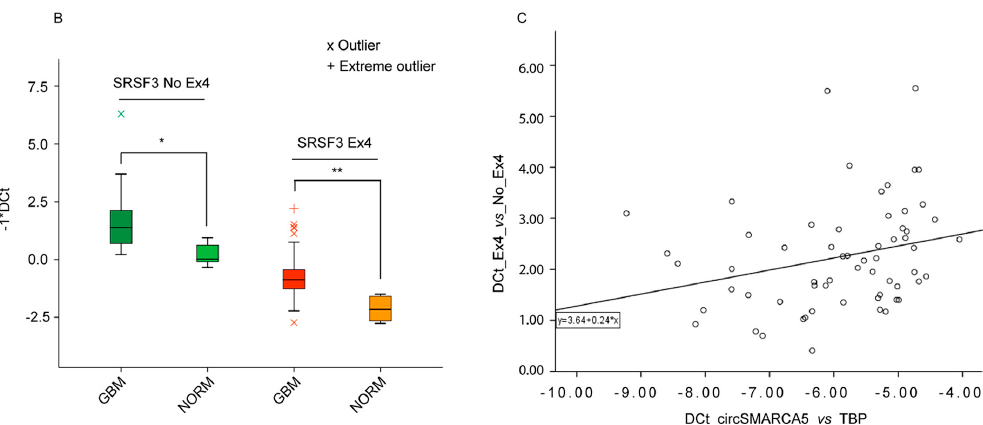
Figure 5. circSMARCA5 stimulates inclusion of exon 4 within SRSF3 mRNA. Graphs representing the expression of the mRNA of the splicing factor SRFS3 in: ( A ) U87MG overexpressing circSMARCA5; and ( B , C ) GBM biopsies. ( A ) U87MG overexpressing circSMARCA5 show a significant increased expression of SRSF3 containing exon 4 ( SRSF3 Ex4 ) (** p -value < 0.01, n = 3, Student’s t -test). Data are reported as fold-change (FC) versus untransfected cells (UC). ( B ) Both SRSF3 No Ex4 and SRSF3 Ex4 are significantly overexpressed in GBM biopsies (GBM) with respect to normal brain parenchyma (NORM) (* p -value < 0.05; ** p -value < 0.01, n GBM = 56, n NORM = 7, Student’s t -test). Expression values are reported as − DCt relative to (mRNA) TBP. ( C ) Correlation between SRSF3 Ex4 / SRSF3 No Ex4 ratio and circSMARCA5 ( r -value = 0.36, p -value = 0.004, Spearman’s correlation test). Data are represented as DCt relative to (mRNA) TBP in a scatter plot.